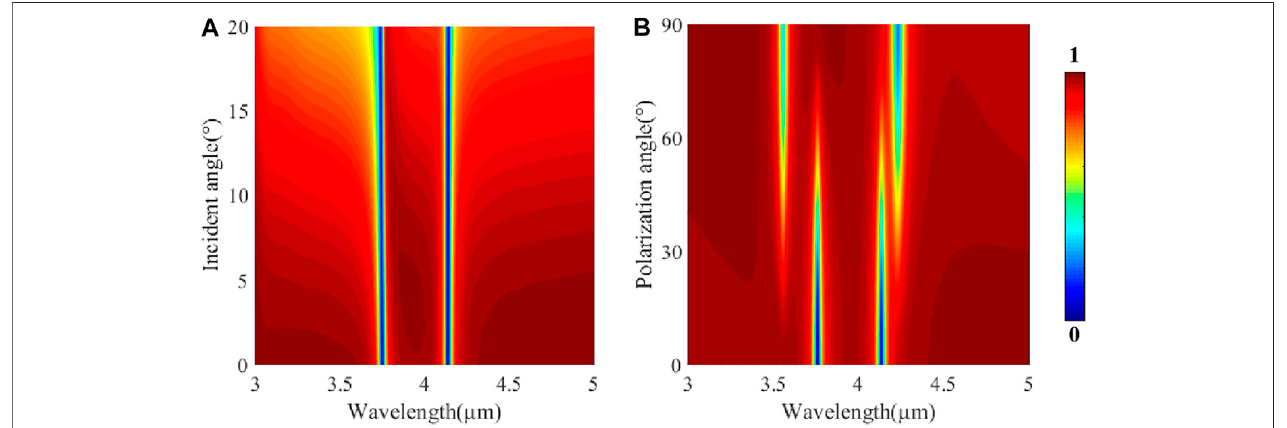
FIGURE 6 | (A) The relation between resonance wavelength and incident angle under TM polarization. (B) The effect of changing the polarization angle of incident light on the re fl ection spectrum.